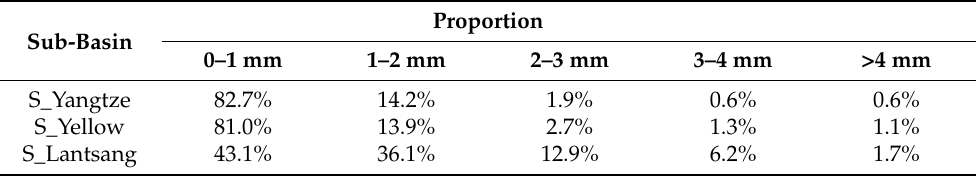
Figure 6. Spatial variation of annual average April 1 SWE: ( a ) from 1971 to 2007; ( b ) 1970s; ( c ) 1980s; ( d ) 1990s; and ( e ) 2001 to 2007 over TRHR. Table 4. Mean proportion of area covered by various peak SWE depth from 1971-2007 over